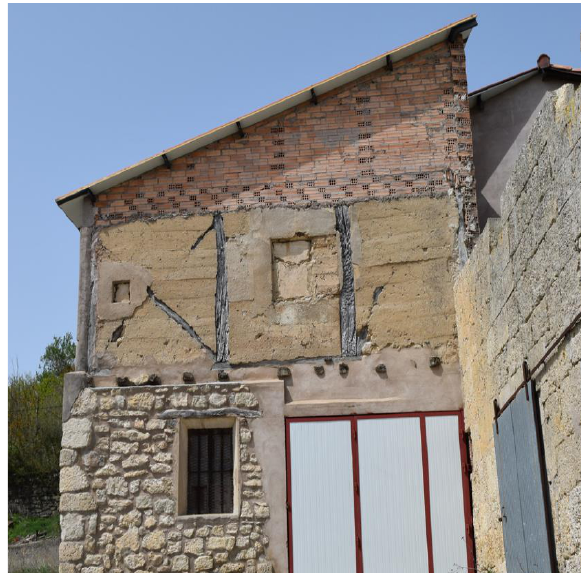
Figure 10. Building in Reinoso (Burgos), extended with brick walls and rehabilitated as a garage.